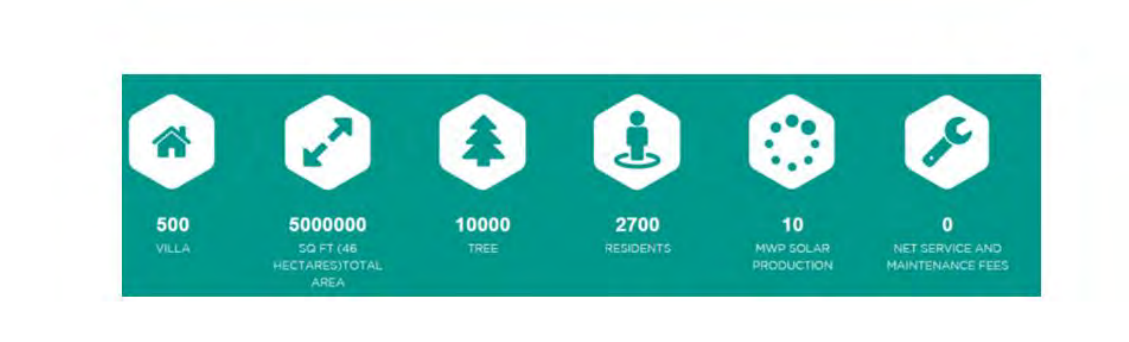
Figure 2. Facts about the City (Diamond,